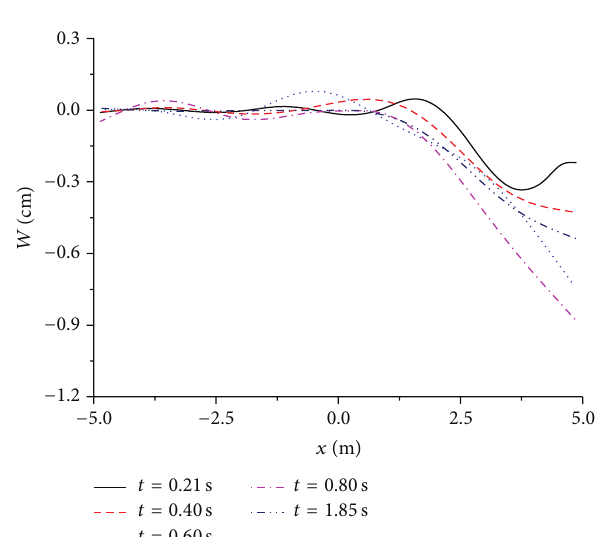
Figure 8: Spatial profiles of the VLFS due to the mass drop.